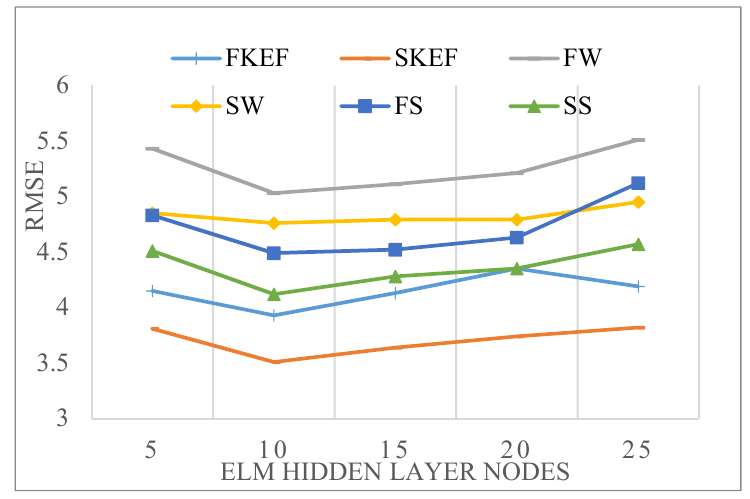
Figure 15. RMSE of prediction results when the number of ELM neurons changes.